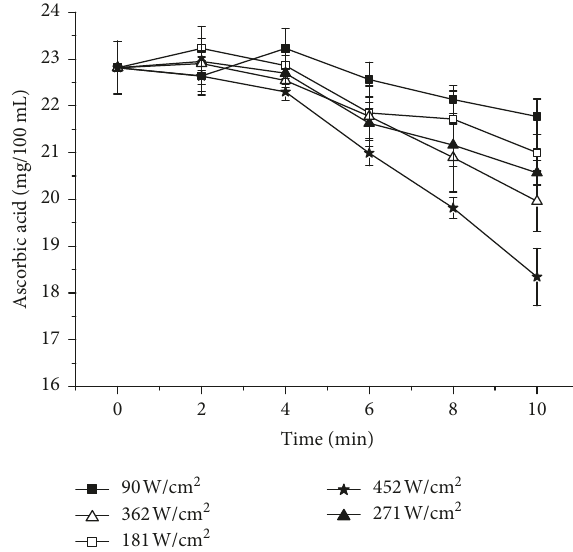
Figure 2: Effects of ultrasound processing on ascorbic acid of bayberry